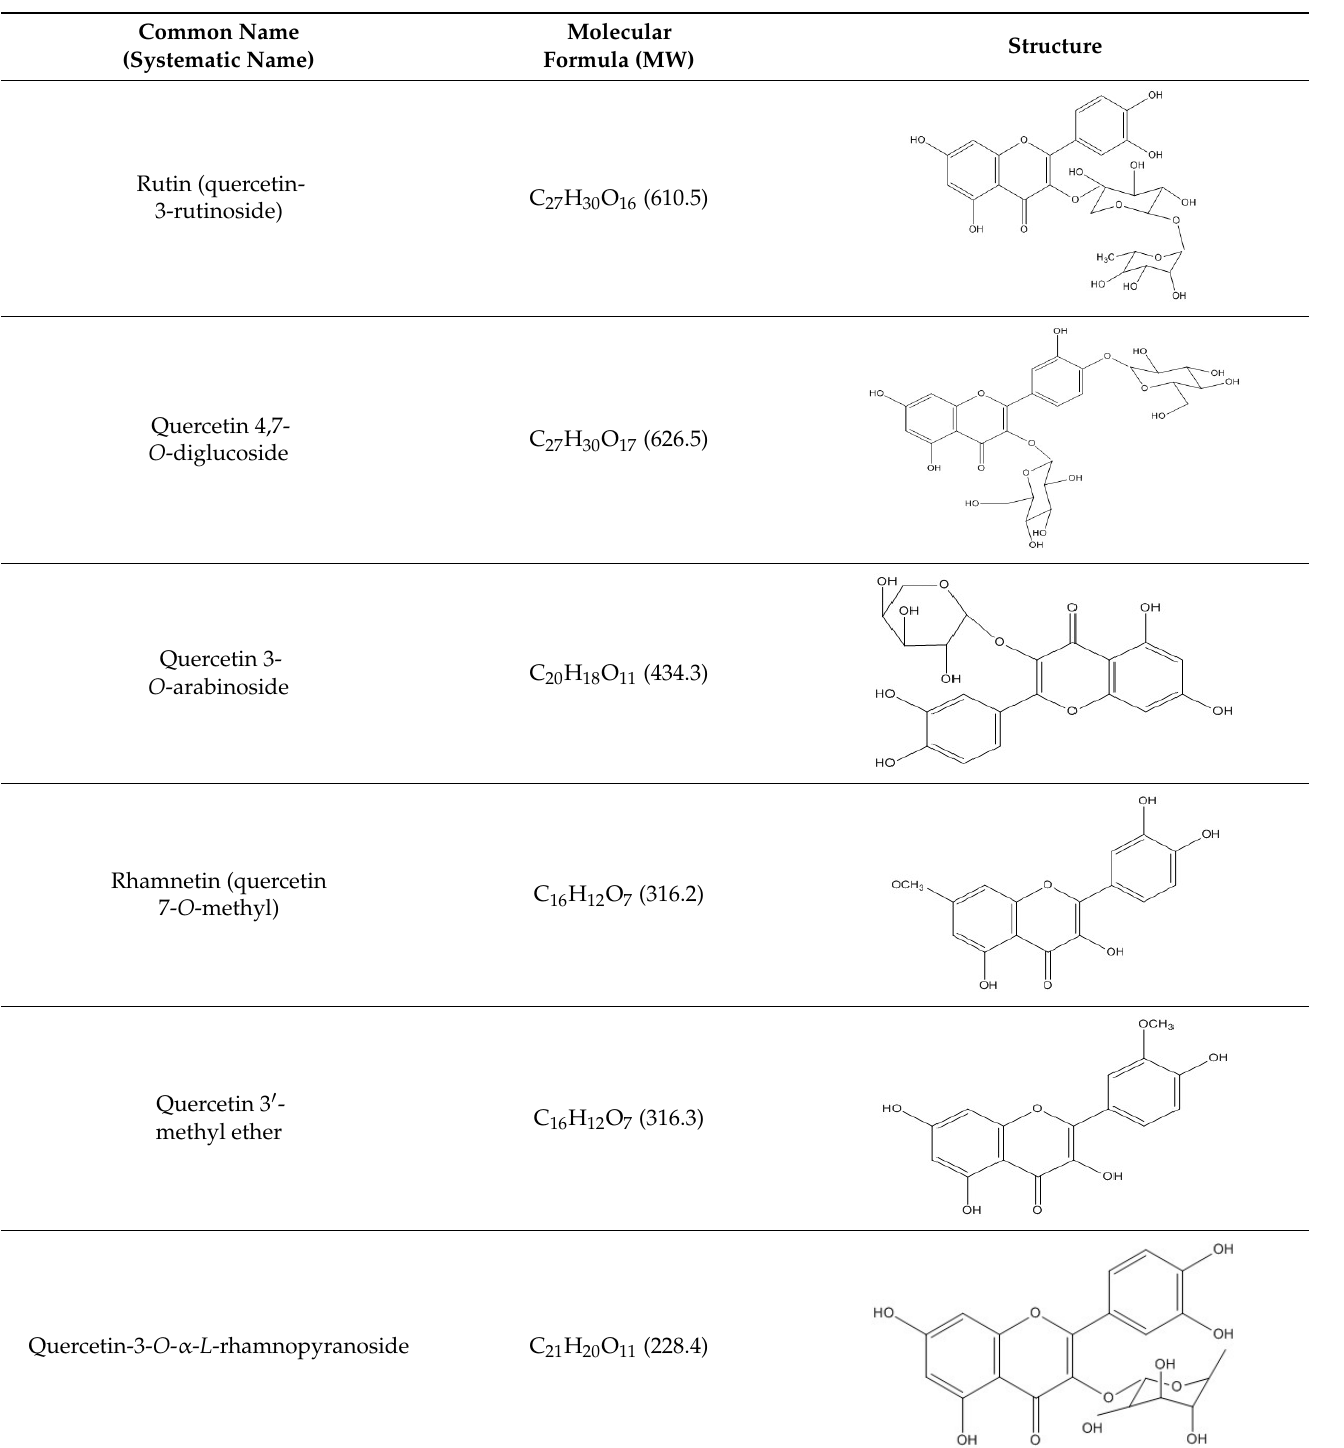
Adapted from Gansukh et al. [75] with